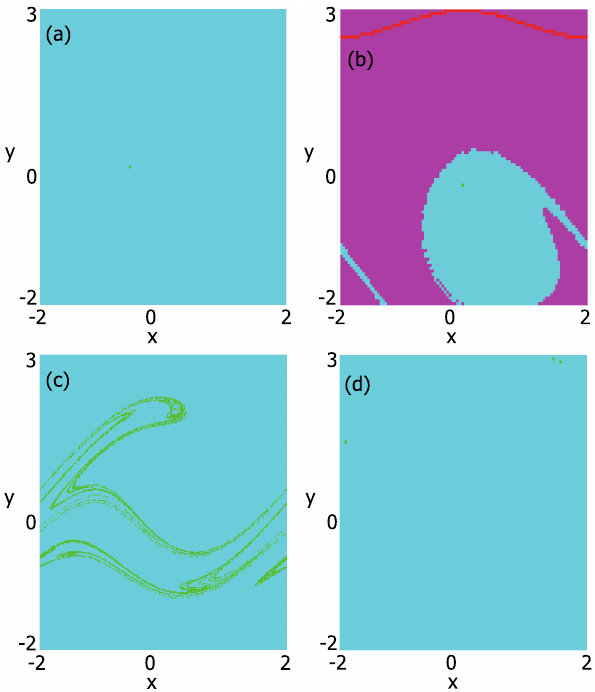
Figure 10. Plots of the basins of attraction of the periodically driven pendulum with a torque for α = 0.15, ω = 1, ( a ) f = 0.25 and ν = 0, ( b ) f = 0.25 and ν = 0.55, ( c ) f = 2.5 and ν = 0 and ( d ) f = 2.5 and ν = 0.55. The blue and pink represent two different basins, and the green dots in ( c ) represent the chaotic attractor. In ( a – c ), the green dots are located in the singular points and corresponds to periodic oscillations. The red dots in ( b ) represent the attractor of the rotational solution. We clearly see the effects of the external torque on both the dynamics and the topology of phase space, showing the appearance and destruction of the attractors. When the external torque is quite large the motion becomes